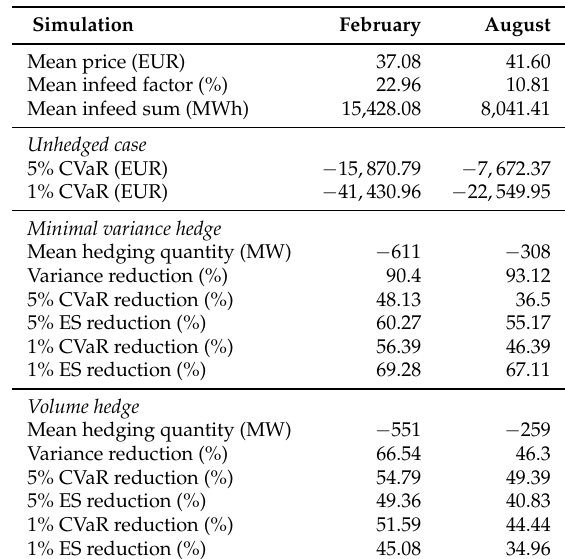
Table 7. Risk assessment for the variance reduced portfolio with and without hedging. Both hedging methods reduce variance and CVaR significantly, with the minimal variance hedge outperforming the volume hedge with respect to expected shortfall. Optimal hedging volumes are reduced compared to the overall